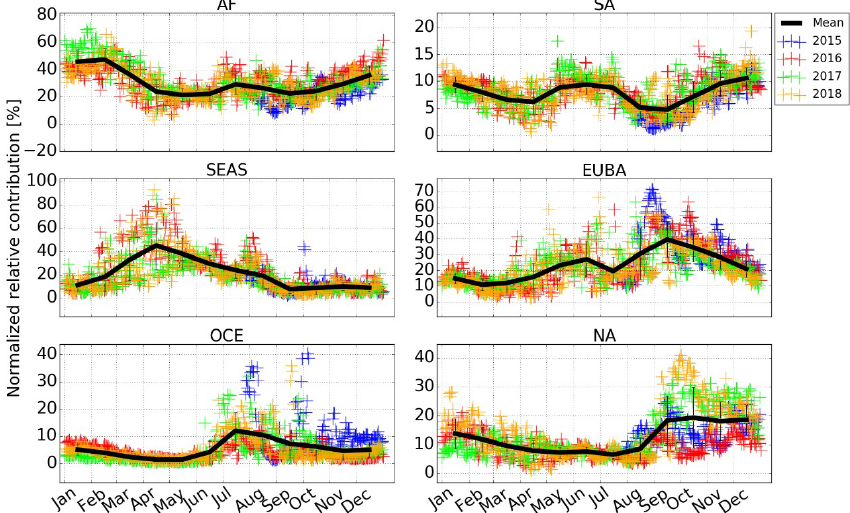
Figure 10. Seasonality of the normalized relative contribution (%) of the AF, SA, SEAS, EUBA, OCE, and NA biomass burning tracers in the GEOS-Chem simulation to the total biomass-burning-associated CO tropospheric column at Hefei (32 ◦